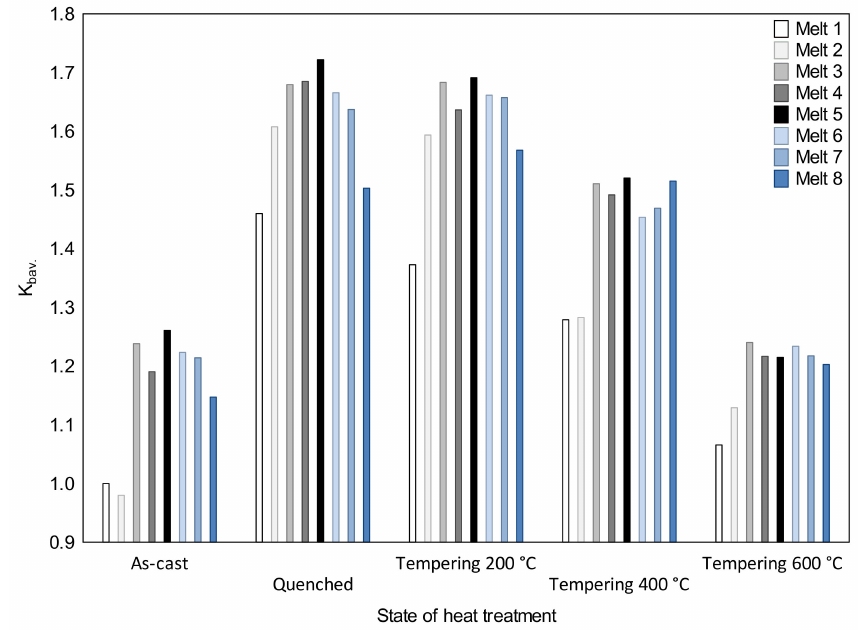
Figure 16. Values of wear resistance index K b of the analyzed as-cast, quenched and tempered at 200, 400 and 600 ◦ C alloys, based on [31,32] and the authors’ own